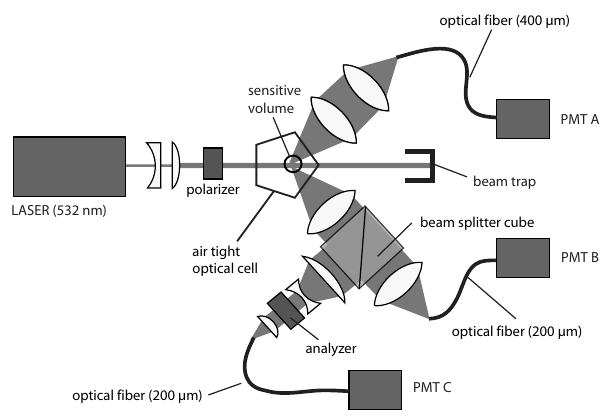
Fig. 1. Optical layout of TOPS-Ice (top